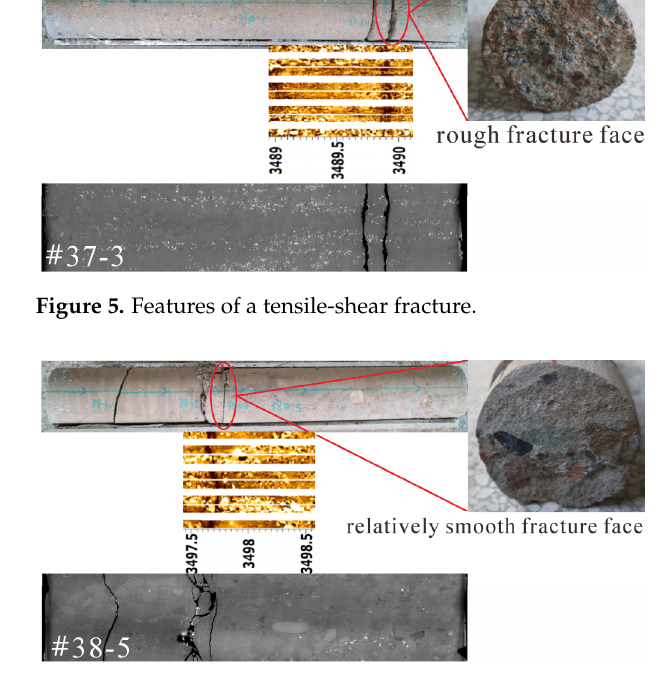
Figure 6. Features of a compression-shear fracture.